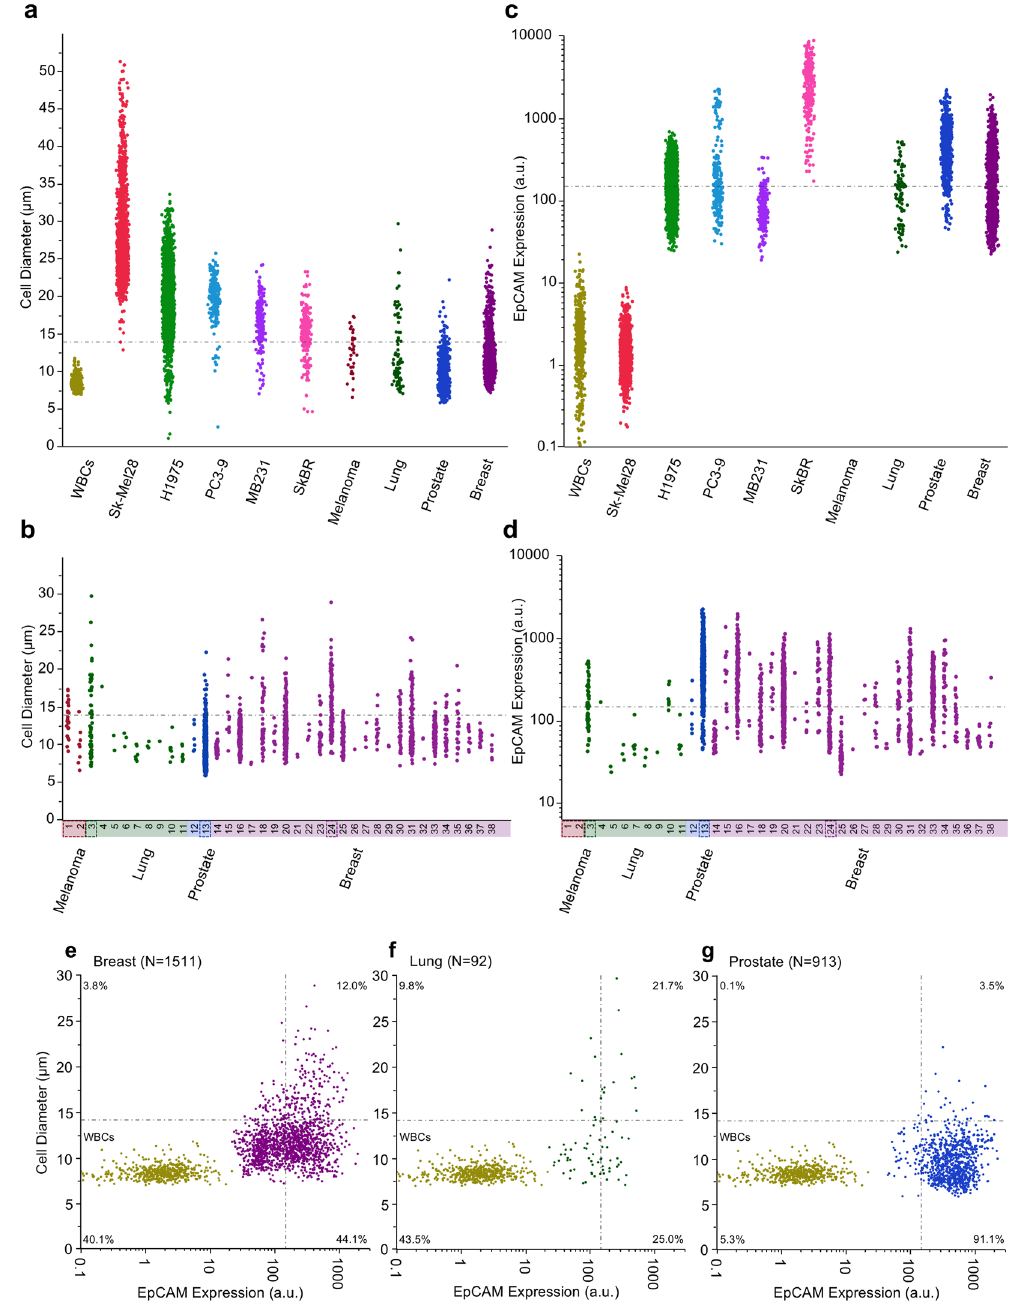
Figure 2. Size and Expression Comparison of Cell Lines and Patient CTCs – The size distributions of the CTCs, cell lines - Melanoma (SK-Mel28 – 2500 cells), Lung (H1975 – 5514 cells), Prostate (PC3-9 – 225 cells) and Breast (MB231 – 201 cells, SkBR – 295 cells) and healthy donor white blood cells obtained via running the CTC-iChip without magnetic beads (1 healthy donor sample – 620 cells) categorized by ( a ) cell population and ( b ) patient. Cell lines were significantly larger than their corollary CTC populations (All p < 0.001 Wilcoxon Rank Sum Test). The horizontal line at 13.9 µ m indicates the size above which there are only 0.1% of WBCs. ( c , d ) The EpCAM expression distributions of the CTCs, cell lines and white blood cells categorized by cell population (left) and patient (right). Note that melanoma patient samples were excluded from the EpCAM measurements as they are generally accepted to not express EpCAM. Cell lines were significantly different in expression than their corollary CTC populations (All p < 0.001 Wilcoxon Rank Sum Test). The horizontal line at 147 a.u. indicates the estimated CellSearch ® threshold for capture. Flow cytometry images from individual patients in four distinct categories emphasizing the heterogeneity of cells even within a single patient are given in Supplementary Figure 9. The patients from which these cells were sampled from are boxed with dashed lines. Size vs EpCAM – A comparative presentation of individual cell expression and size for patient CTCs with WBCs presented as a reference point for all ( e ) breast cancer, ( f ) lung cancer and ( g ) prostate